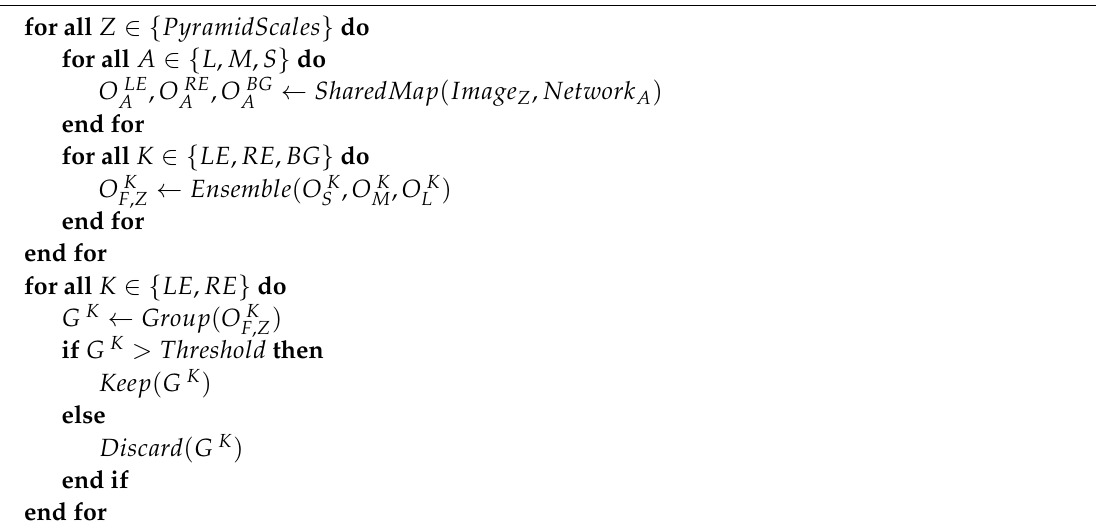
Algorithm 1 The proposed process including steps for inference, grouping, and applying the threshold.